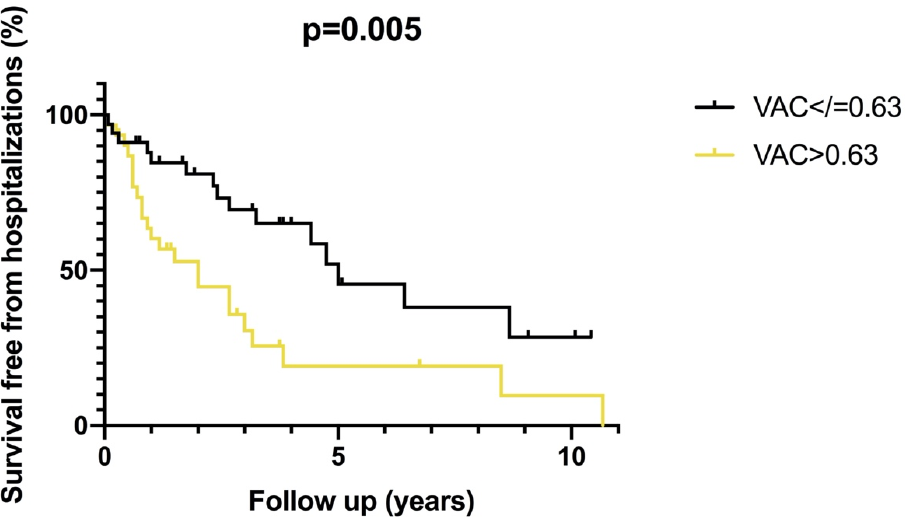
Figure 2. Kaplan Meier estimate of survival free from hospitalizations of patients with VAC ≤ 0.63 (in black), and patients with VAC > 0.63 (in yellow).